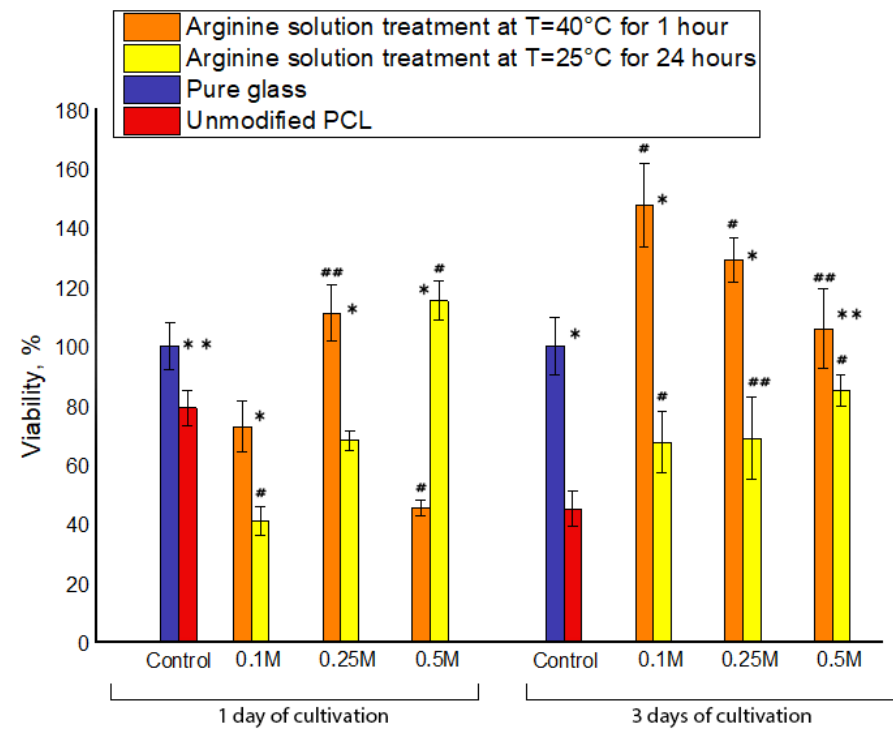
Figure 4. The dependence of viability of the MSC cells on the type of treatment of PCL films and the duration of cultivation (n = 5: *— p < 0.01, **— p < 0.05 for the same concentration data, #— p < 0.01, ##— p < 0.05 compared with the unmodified PCL).